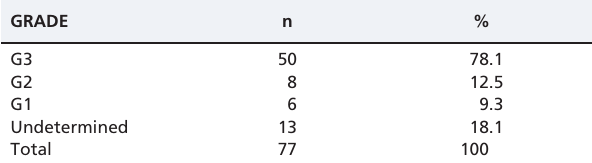
Table 2 - Grade of STS in 64 patients submitted to pulmonary metastasectomy.